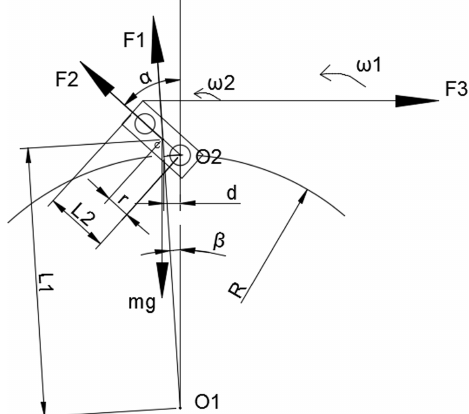
Figure 2. Motion diagram of the hammer slice. O 1 – spindle axis; O 2 – pin axis; R – the spin radius of the pin around the spindle; C – hammer slice